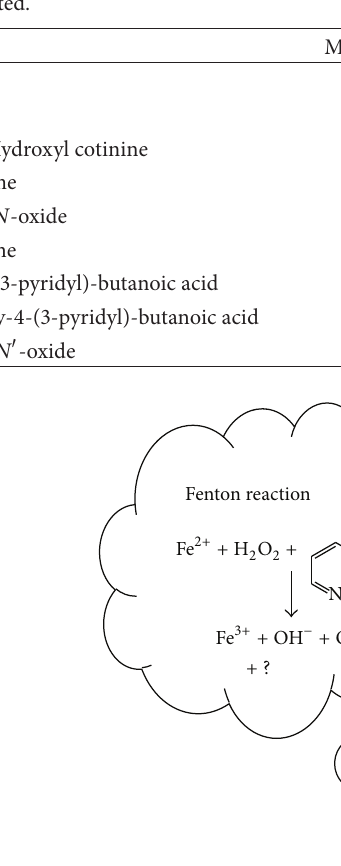
Table 1: Metabolic derivatives of nicotine in EEO/ESI-MS/MS. The molecular formula, molecular weight, and 𝑚/𝑧 of parent ion and daughter ions are listed.